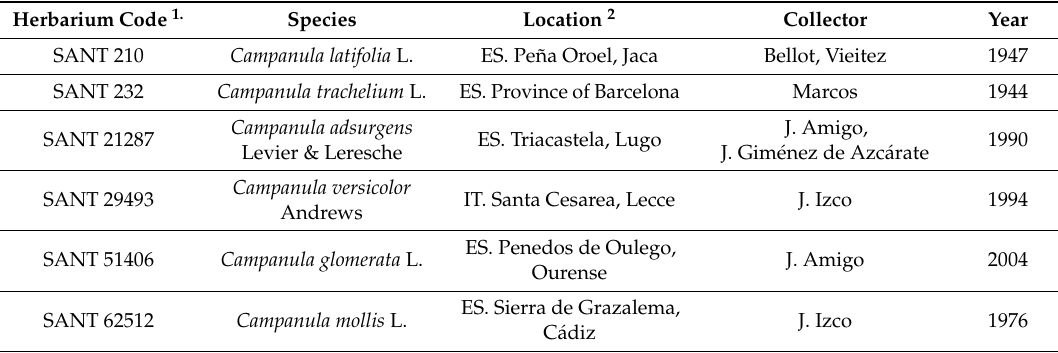
Figure 2. Pictures of herbarium plant specimens used in the study. From left to right and top to bottom: ( a ) Campanula latifolia L., ( b ) Campanula adsurgens Levier & Leresche, ( c ) Campanula mollis L., ( d ) Campanula trachelium L., ( e ) Campanula glomerata L., and ( f ) Campanula versicolor Andrews. Scale bars are 2 cm. Table 1. Data of the six herbarium samples belonging to the Campanulaceae family and used in this study. Herbarium Code